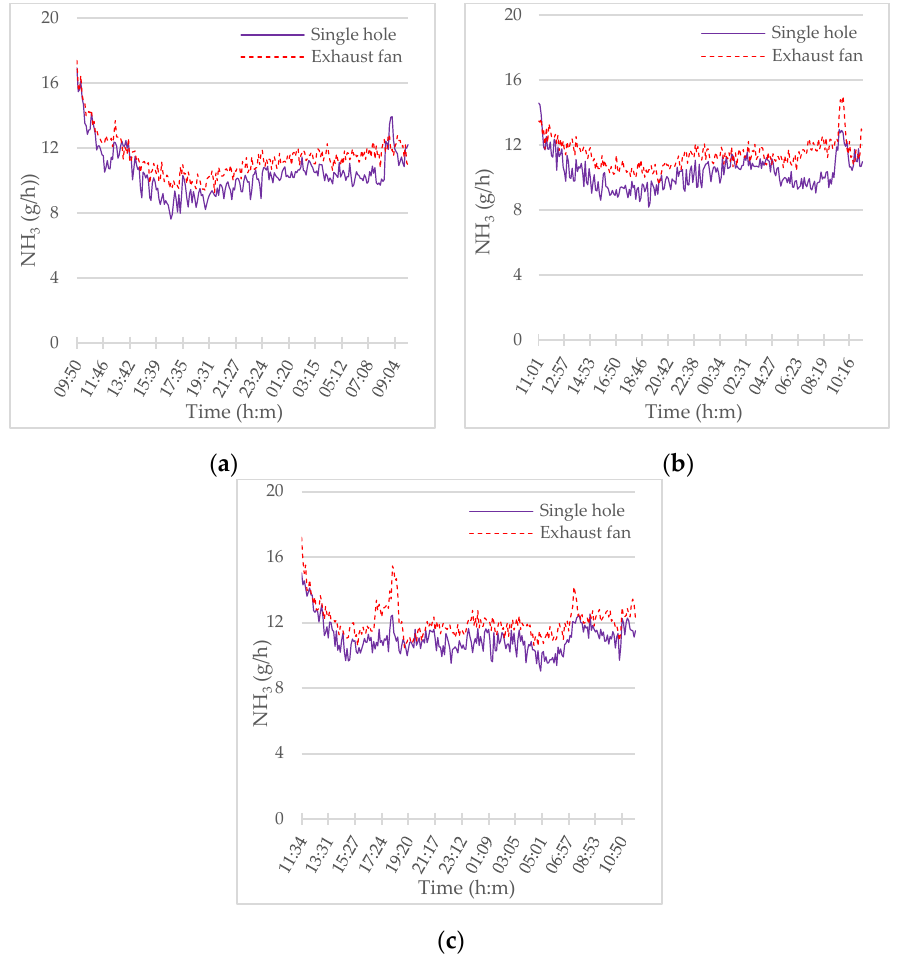
Figure 5. The ammonia (NH 3 ) reduction effect by spraying water inside of the curtain at the maximum operating rate of the barn exhaust fan (100%), ( a ) S/P (spray time, min./pause time, min.) 10/30, ( b ) 10/10, ( c )